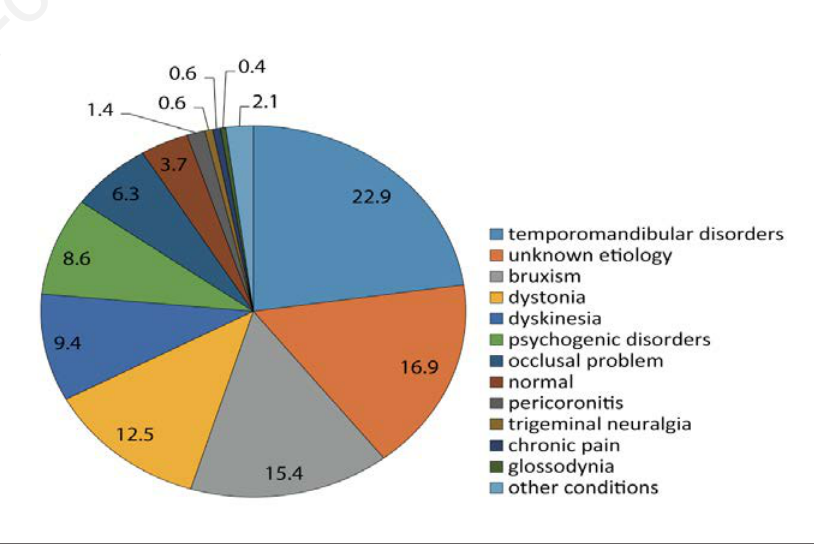
Figure 4. Percentage of alternative or uncertain diagnoses before the patients visited our clinic. Only 12.5% of the patients had been diagnosed with or were suspected to have dystonia before they visited our clinic. The most frequent misdiagnosis was temporo- mandibular disorders